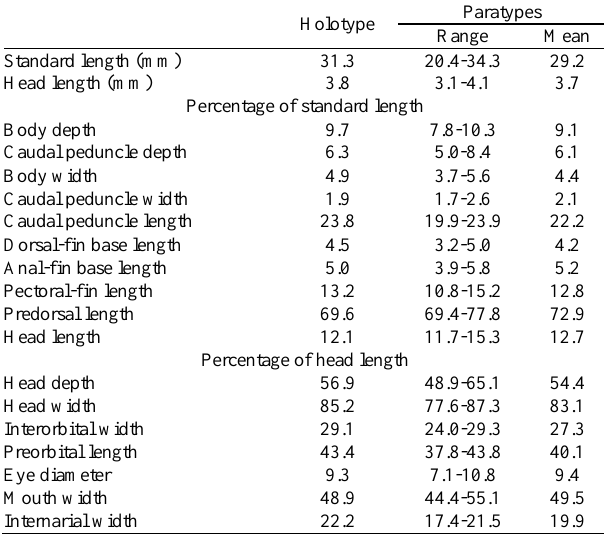
Table 1. Morphometric data of holotype and 14 paratypes of Listrura costai , new species.